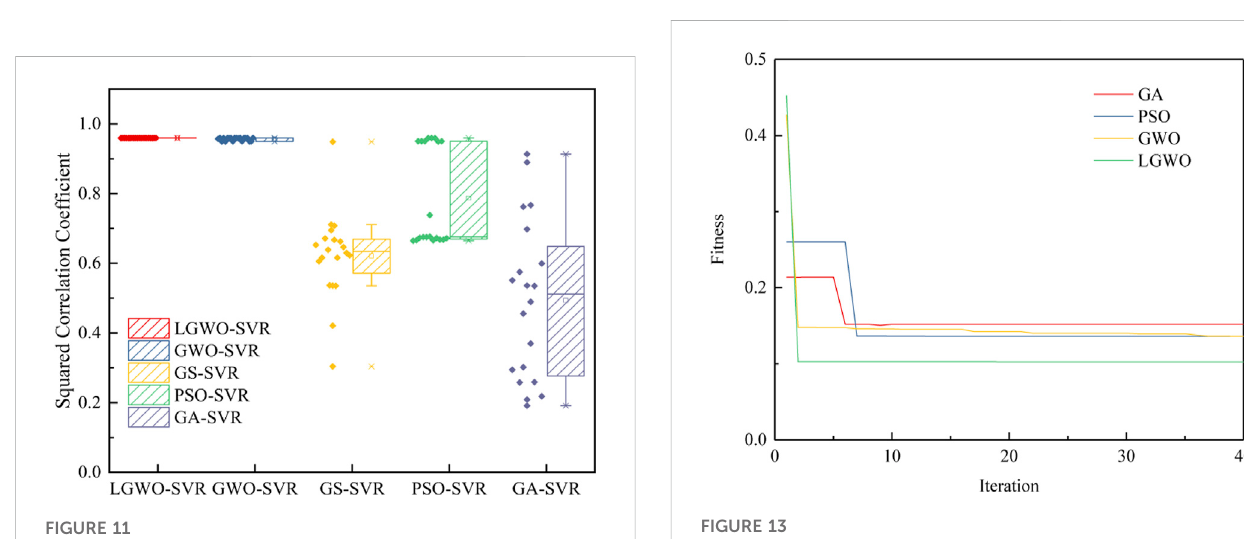
FIGURE 11 The distribution of R2 at each run of each